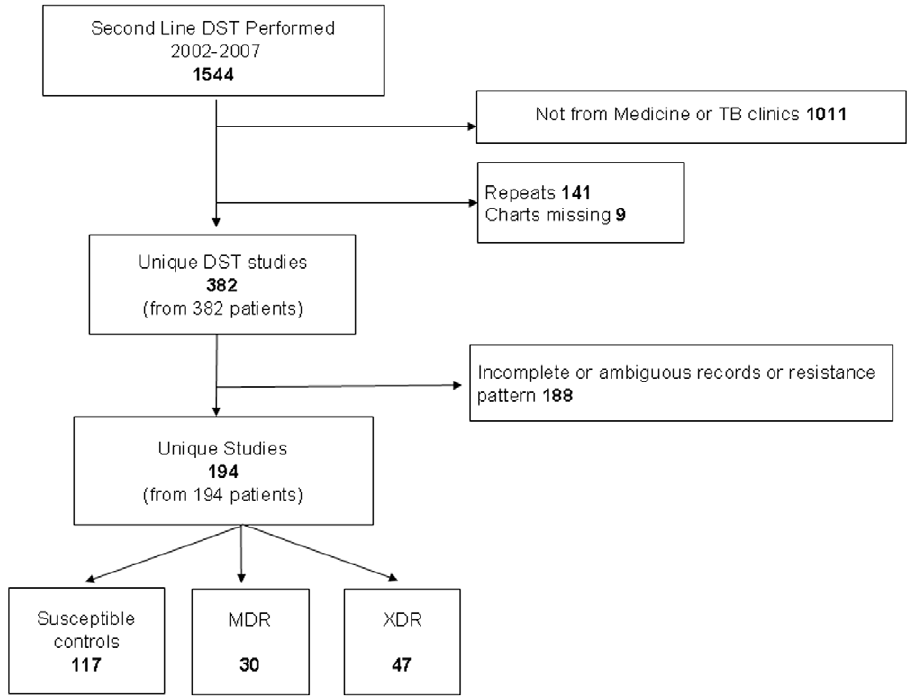
Figure 1. Recruitment.